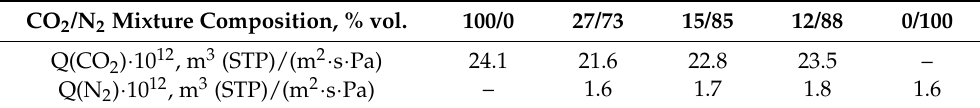
Table 6. Permeance of CO 2 /N 2 mixtures of various compositions at 25 ◦ C. CO 2 /N 2 Mixture Composition, % vol.